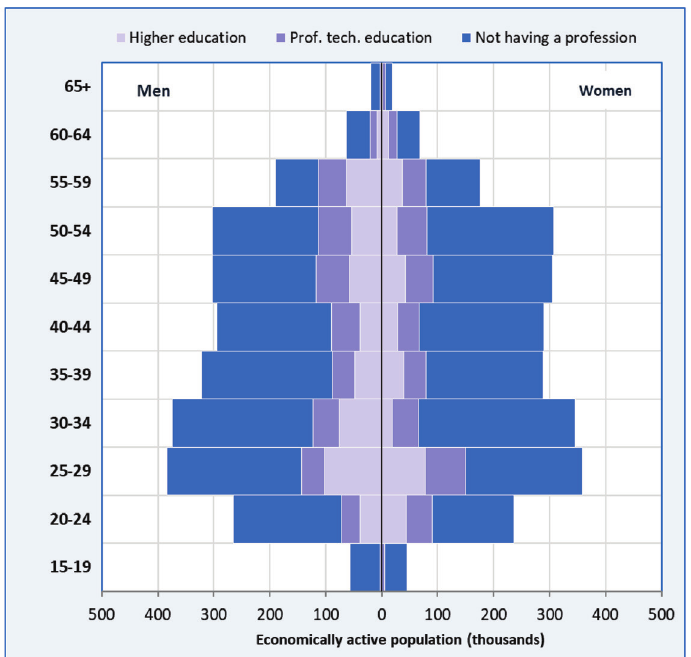
Figure 28. Sex and age structure of economically active population of Azerbaijan by level of educa- tion, 2015. Source: according to SSC